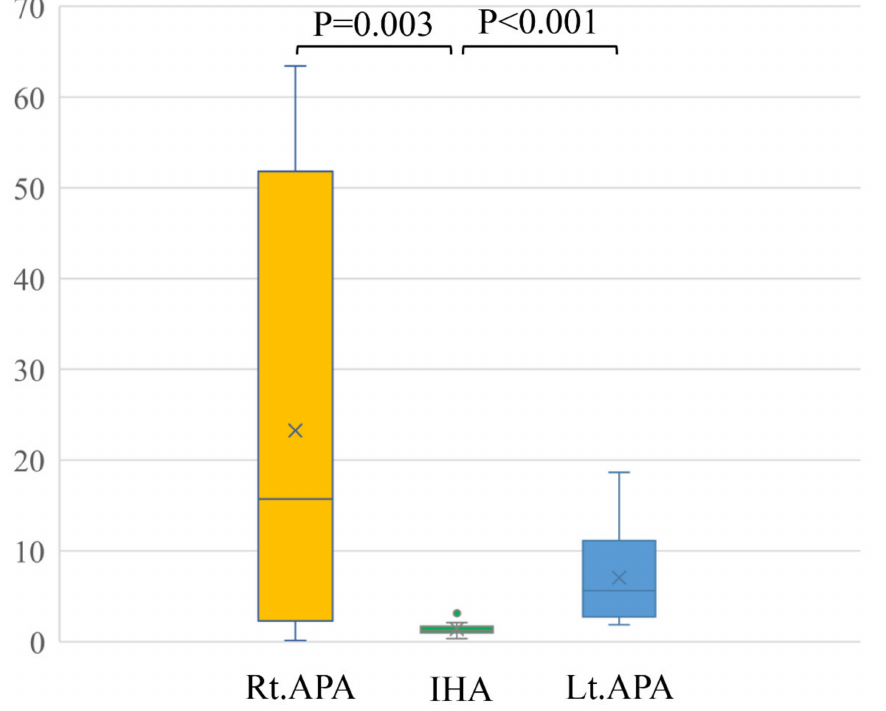
Figure 3. Conventional LIs of right APA (23.3 ± 25.8) and left APA (7.0 ± 5.3) were significantly higher than that of IHA (1.8 ± 2.5) ( p = 0.003 and p < 0.001).